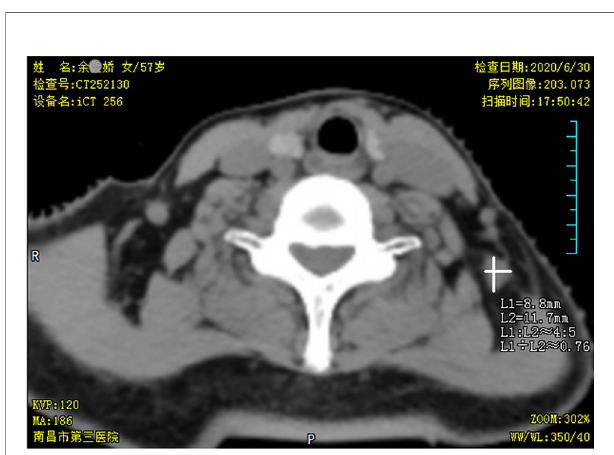
FIGURE 2 | Neck computed tomography (CT) scan fi ndings. Pretreatment axial neck computed tomography (CT) slice taken inthe region of supraclavicular fossa revealed a 1.2 * 0.9-cm soft tissue mass innodal level V.